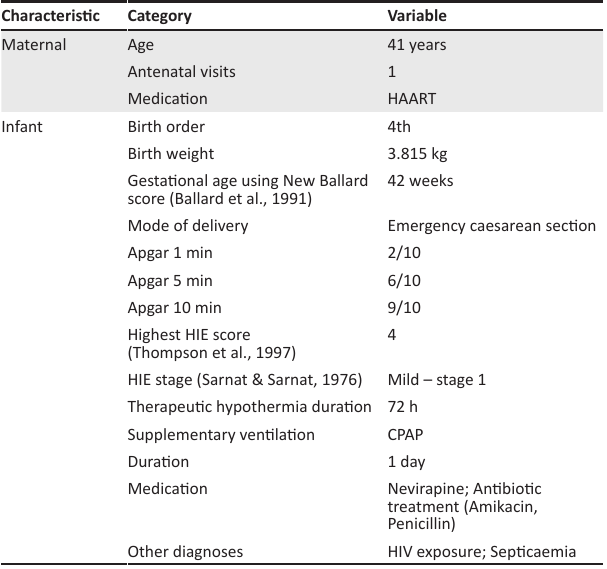
TABLE 1: Maternal and infant characteristics. Characteristic